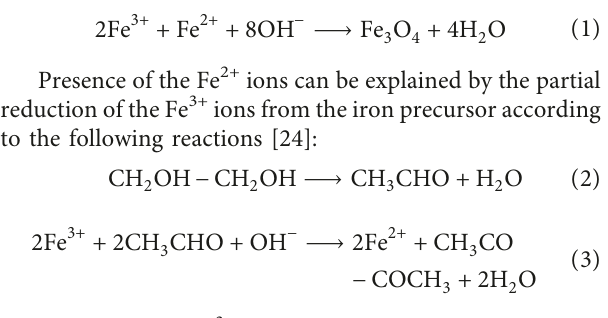
Figure 1: XRD patterns of (1) MNP-Gd0%, (2) MNP-Gd0.5%, (3) MNP-Gd0.6%, (4) MNP-Gd2.5%, (5) MNP-Gd4.3%, and (6) MNPGd5.1%. The solid dots indicate the diffractions of the pure magnetite phase (JCPDS